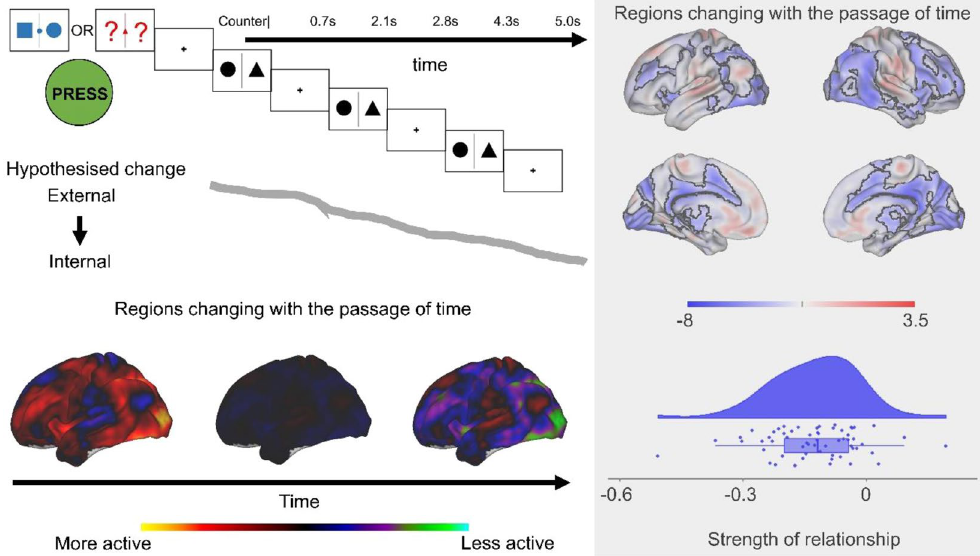
Figure 1. Brain regions change over time following task performance. This analysis looked for significant relationships between brain activity and the passage of time following a task event (target or thought probe: top right). This was based on the idea that external attention is established during external behaviour and then becomes subject to intrinsic influences with the passage of time while the participant remains uninterrupted. We found several large clusters of activity that showed a pattern of significantly decreasing activity with each non-target trial after the performance of an action (left). The global change in activity over time is represented by the unthresholded images in the bottom left. Neural results in the right hand panel are corrected at a cluster forming threshold of Z > 3.1, FWE-corrected p <